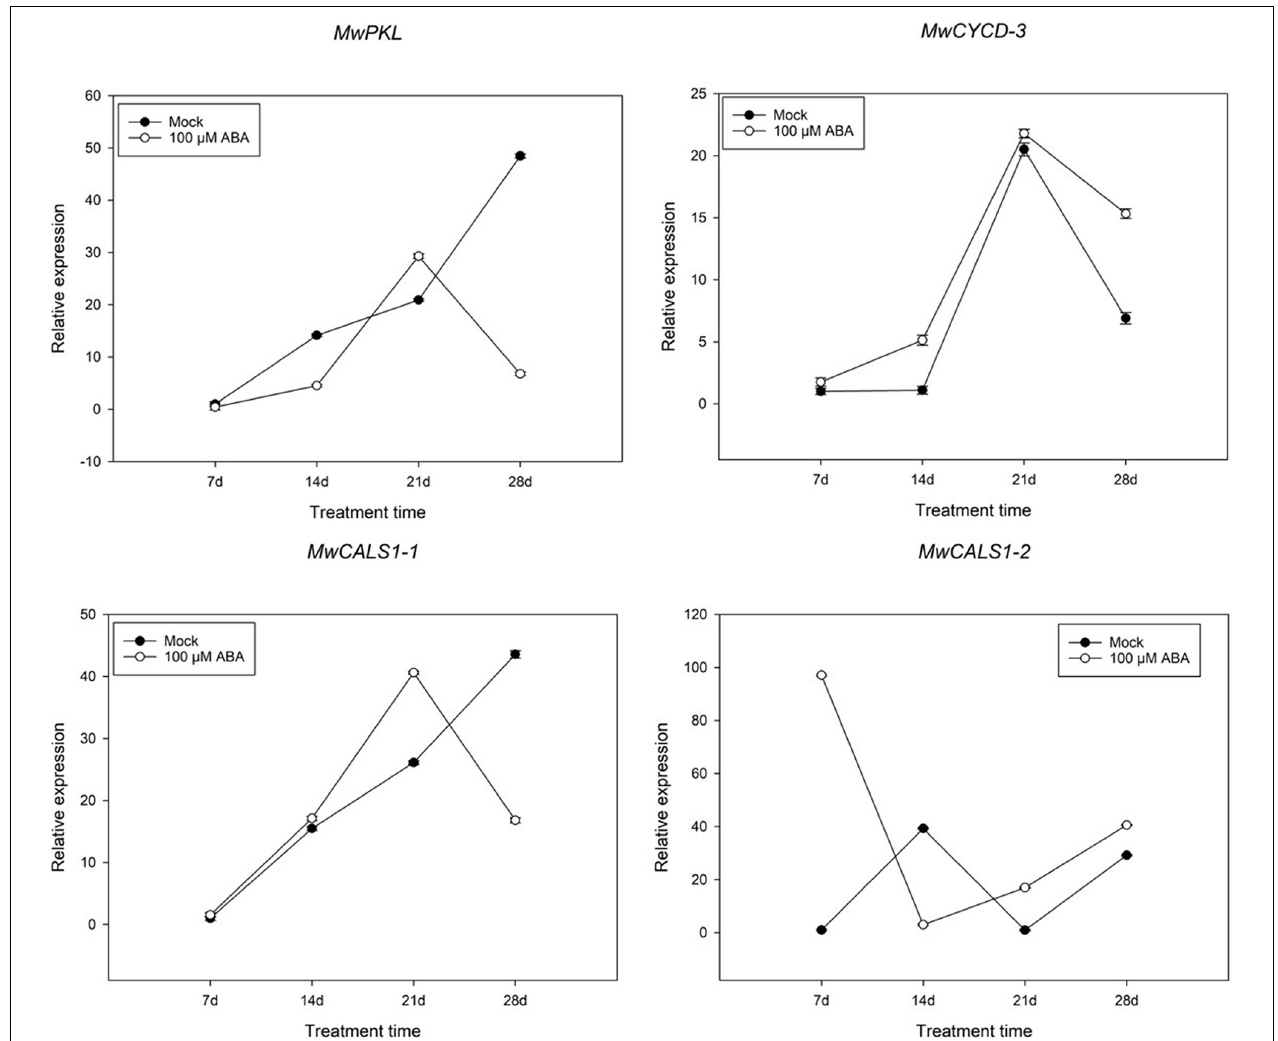
FIGURE 9 | Relative gene expression levels of specific differentially expressed genes (DEGs) involved in bud dormancy under ABA treatment during 2020–2021 in Magnolia wufengensis . Each experiment was performed with three biological replicates. Each bar represents the mean ± SEM of three biological